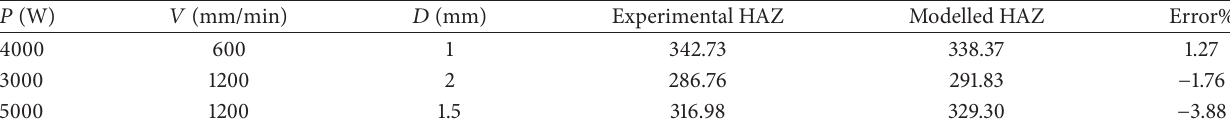
Table 5: Confirmation experiments—HAZ.